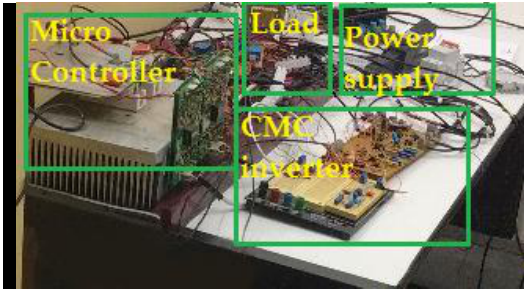
Figure 9. Laboratory setup of proposed H7-type inverter.